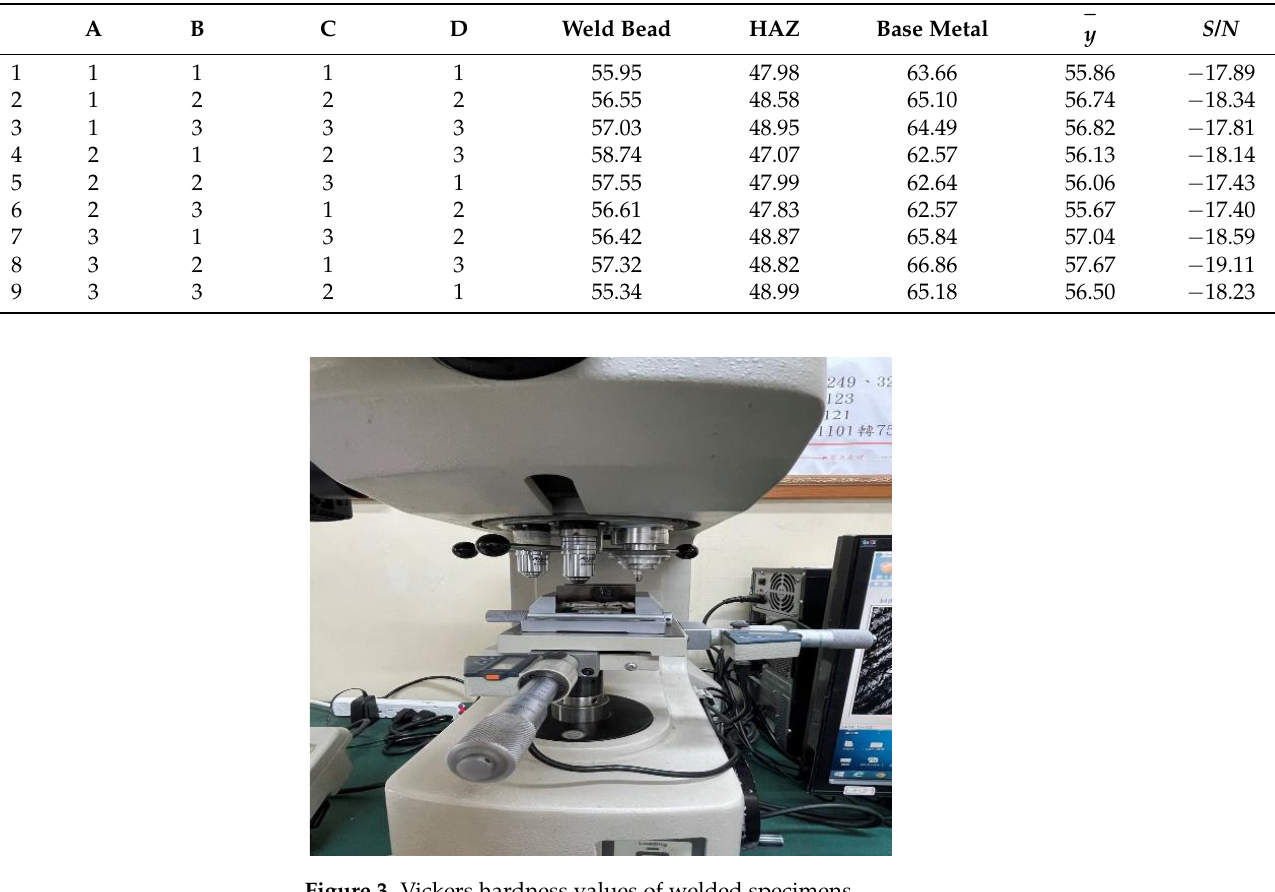
Table 4. The percentage of ferrite iron measured in the duplex stainless steel material.